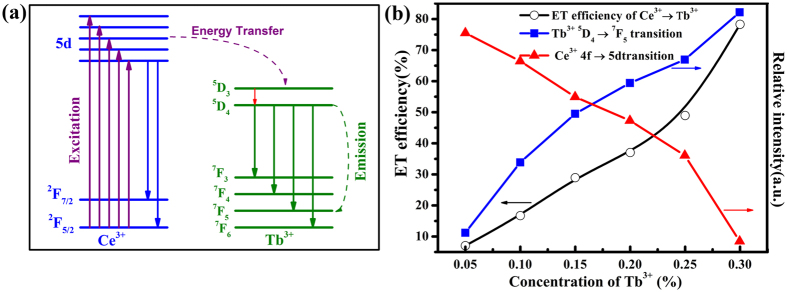
(a) The energy levels model for the energy transfer processes of Ce3+ → Tb3+. (b) The dependence of the emission of the Ce3+ ions and Tb3+ ions, and the energy transfer of Ce3+ → Tb3+ on the doping concentration of the Tb3+ ions in the NaBa3La3Si6O20:0.007Ce3+, yTb3+ phosphors.